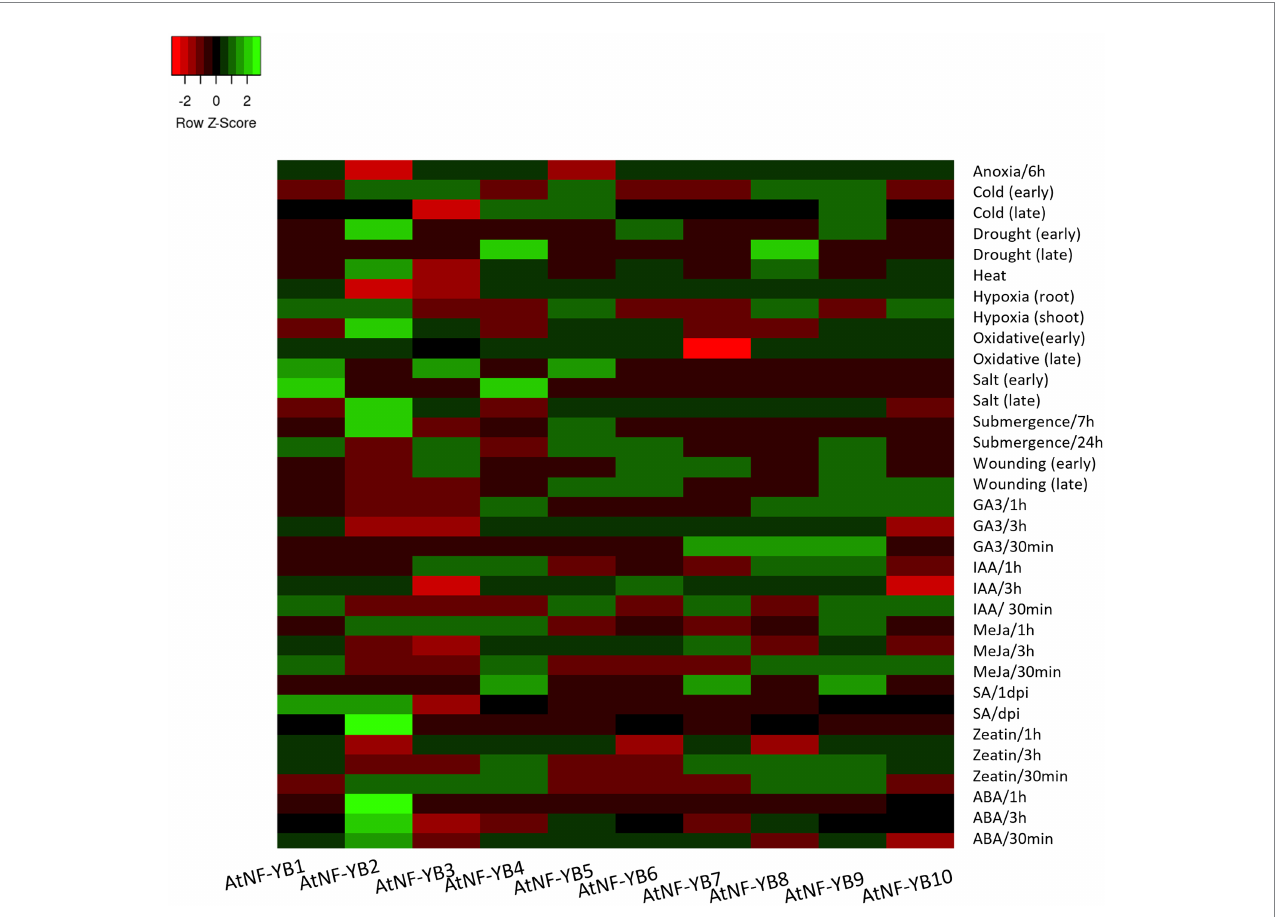
FIGURE 6 Heat map showing the expression profiles of 10 AtNF-YB genes under different abiotic stress conditions. The colour scale is representative of the log2- transformed relative gene expression that is observed under control conditions. Red to green colours denote low to high relative expression